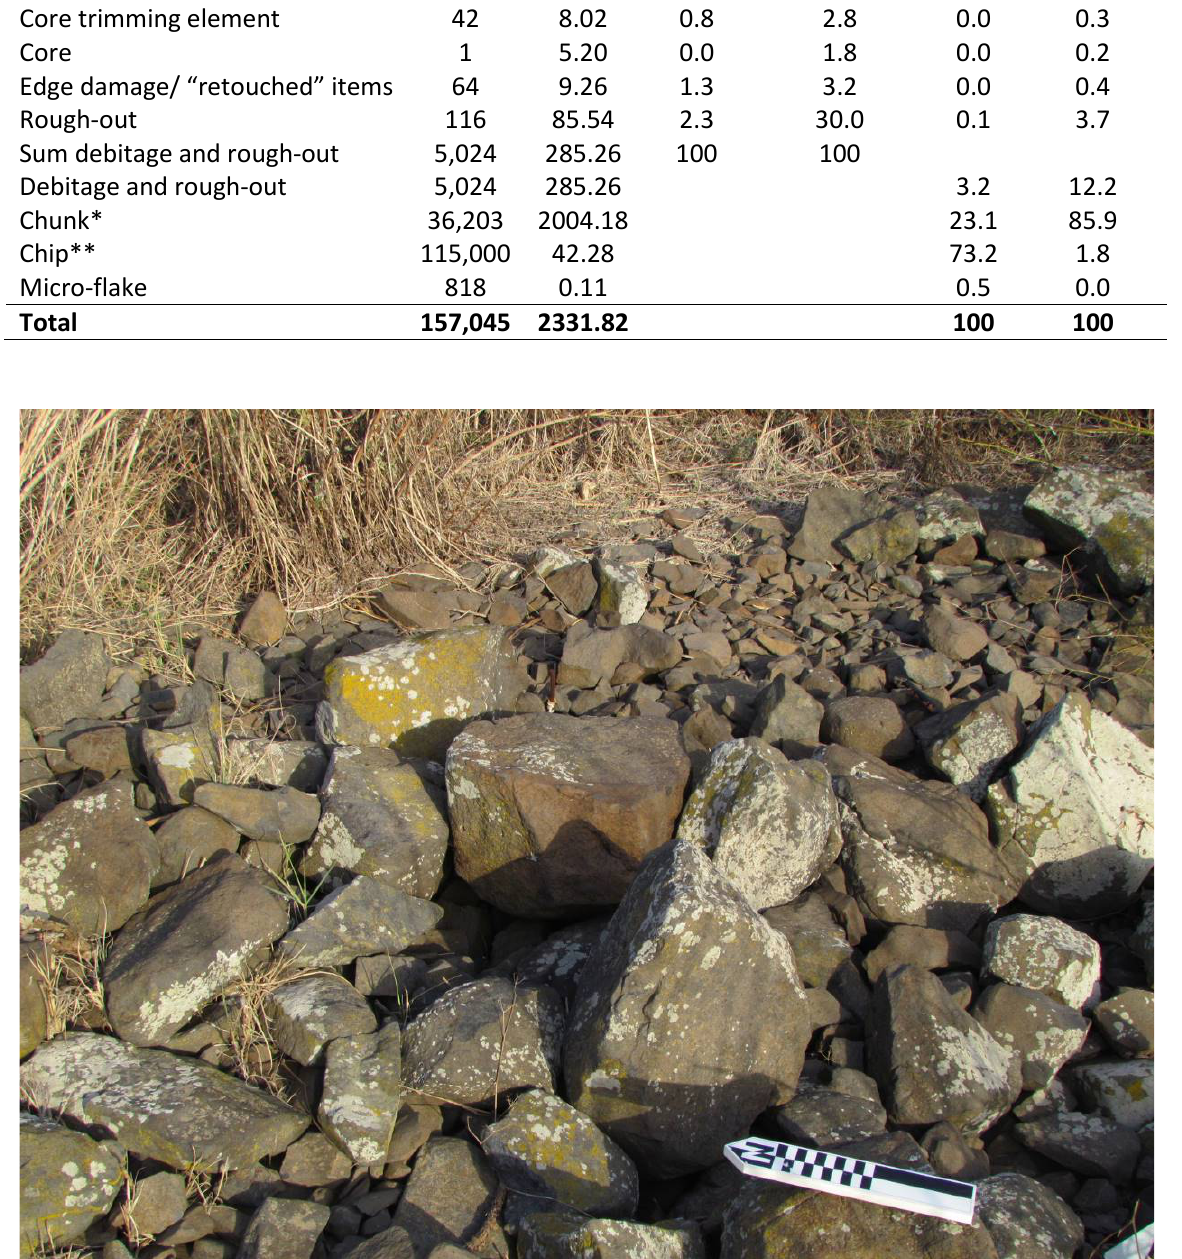
Figure 7. Large boulders, 'giant cores' and other waste material on the surface of Locus